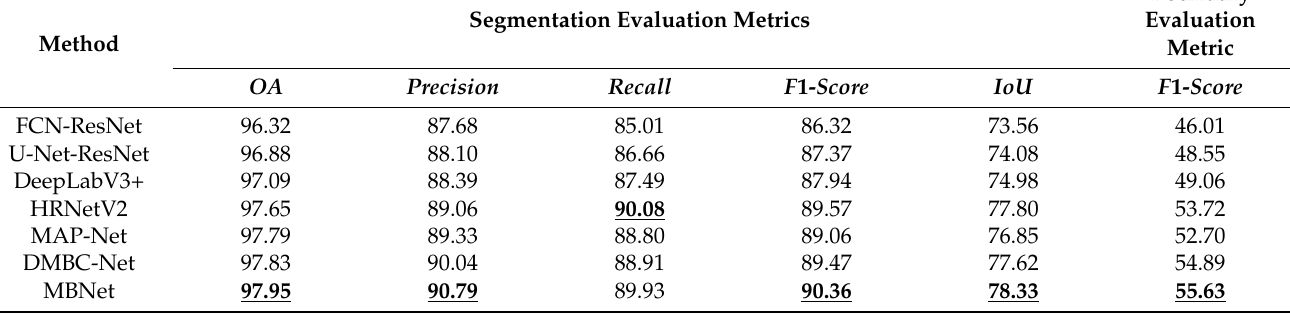
Figure 8. Segmentation results of the different SOTA methods on the mountain landform scene 3 test dataset. The bottom row is a close-up view of the red box. dataset. The bottom row is a close-up view of the red box. Table 2. Quantitative evaluation (%) of several SOTA algorithms on remote sensing images of plain landforms in the test set, where values in bold and underlined are the